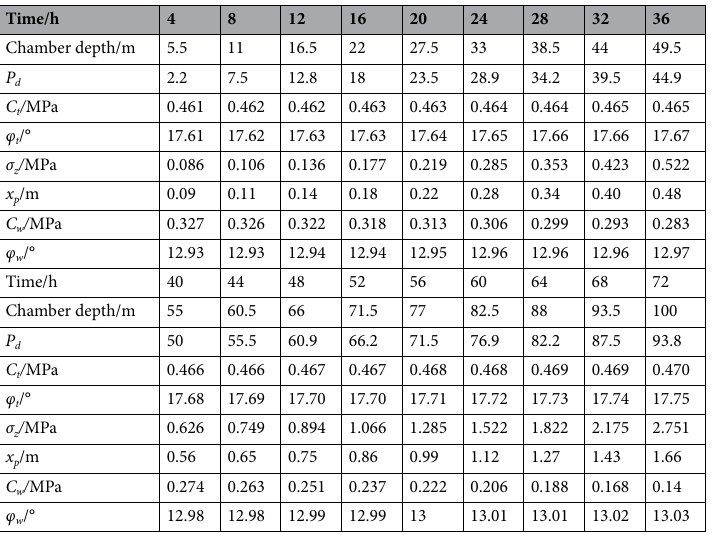
Table 3. Slice width distribution pattern and evolution weak layer parameters of a 5.6-m-wide coal pillar.